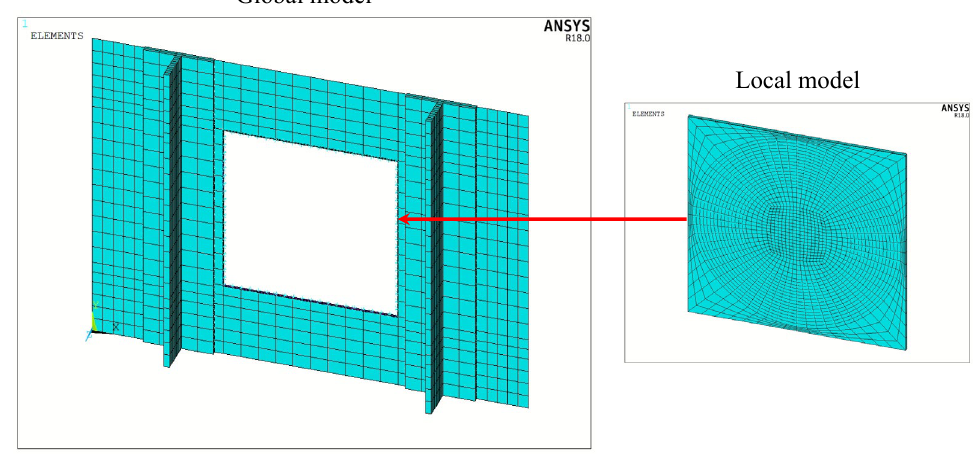
Figure 2. Global –local approach. Figure 2. Global–local